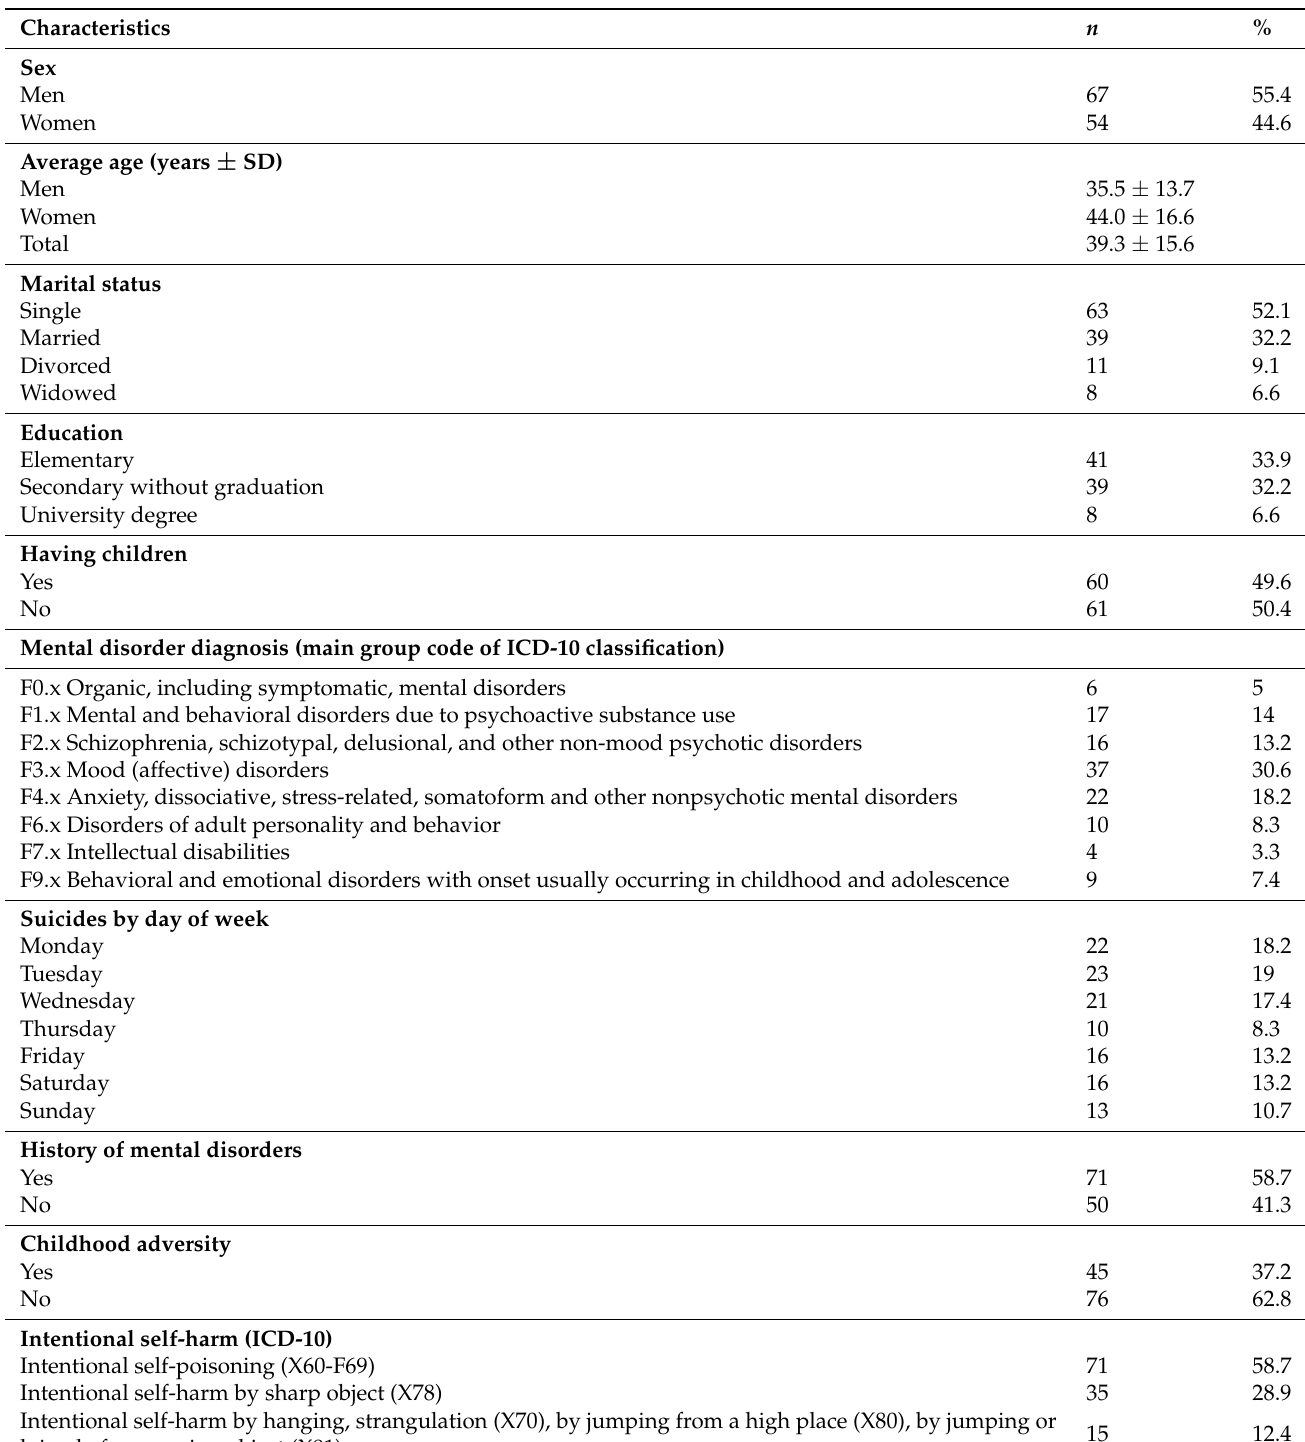
Table 1. Socio-demographic characteristics of the